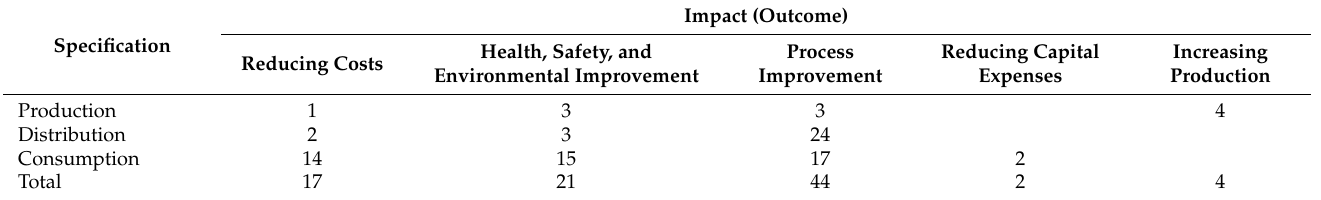
Table 9. The impacts of digitalization in the energy production, distribution, and consumption sectors 1